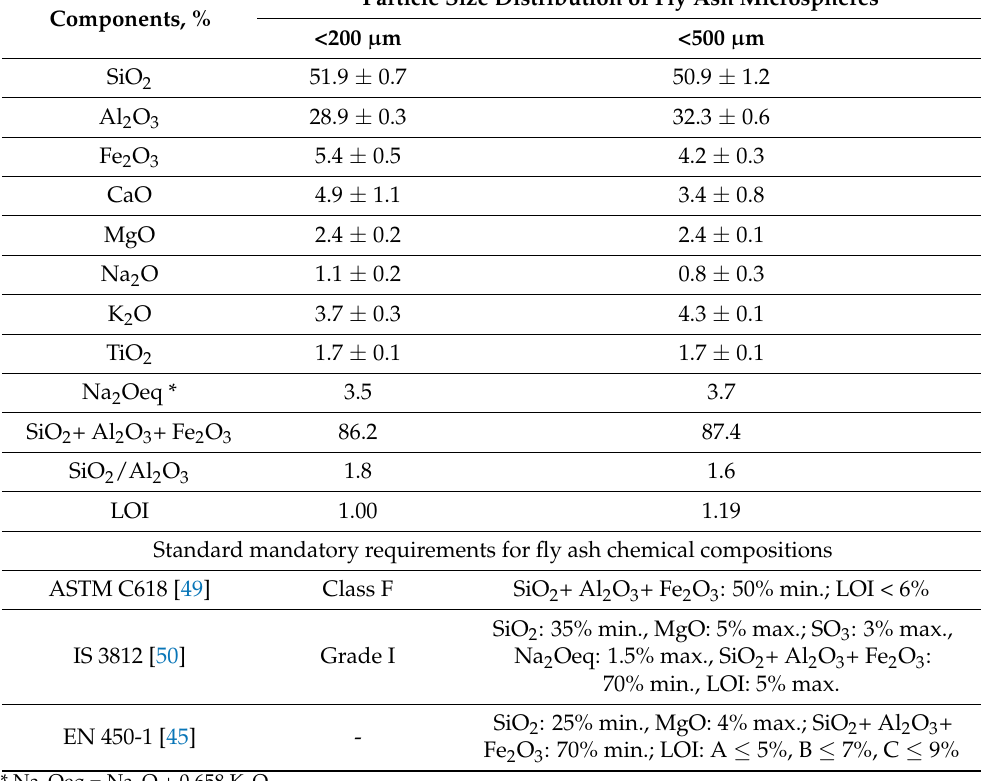
Table 2. Chemical composition of the microsphere fractions with standard deviations determined via X-ray EDS. Particle Size Distribution of Fly Ash Components, %